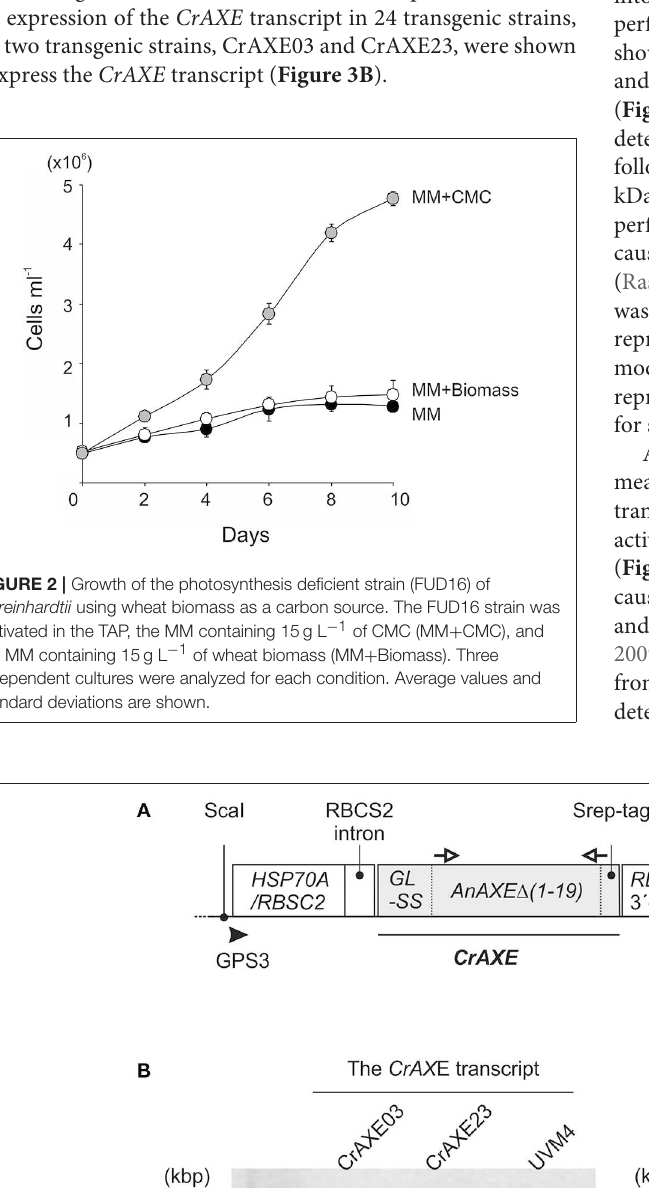
Frontiers in Bioengineering and Biotechnology |